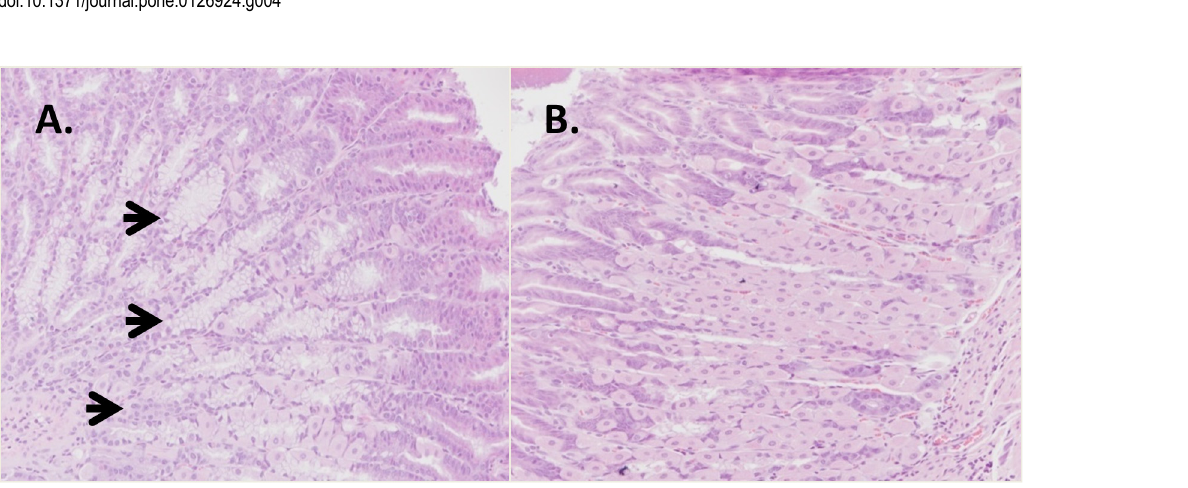
PLOS ONE | DOI:10.1371/journal.pone.0126924 June 17,